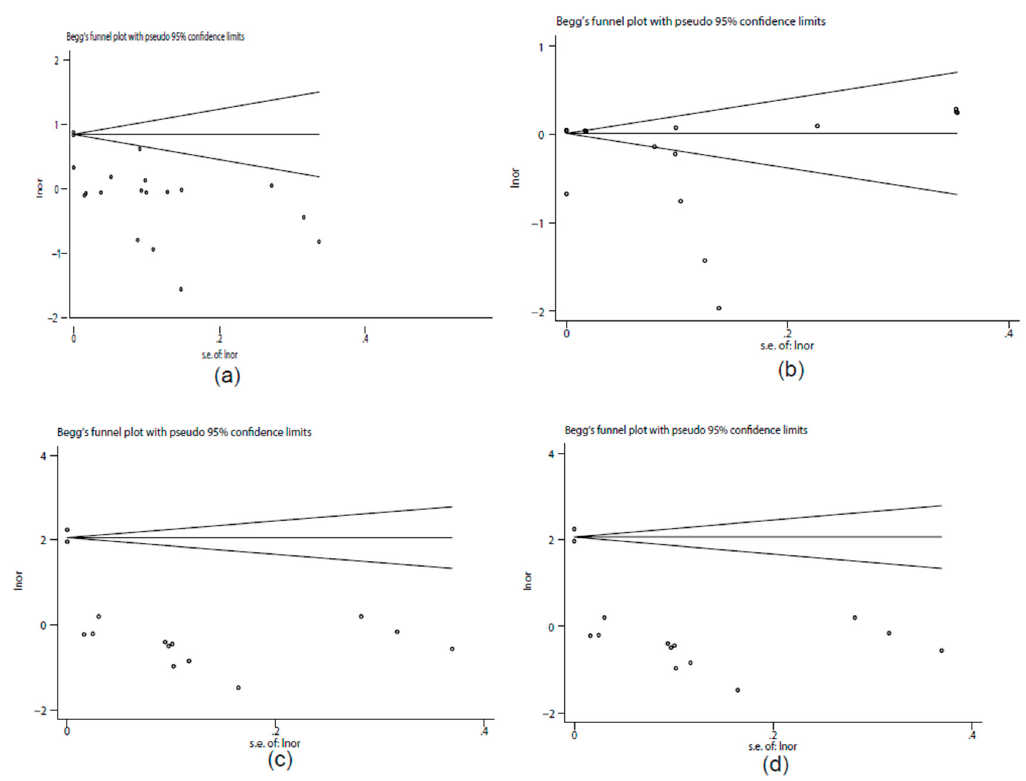
Figure 4. Begg’s funnel plot of publication bias. ( a ) PFOA; ( b ) PFNA; ( c ) PFHxS; ( d )